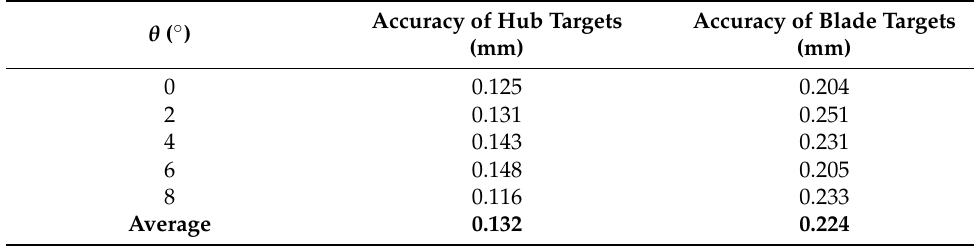
Figure 16. Blade deformations over its full rotating range with the collective pitch angle of θ = 8°.